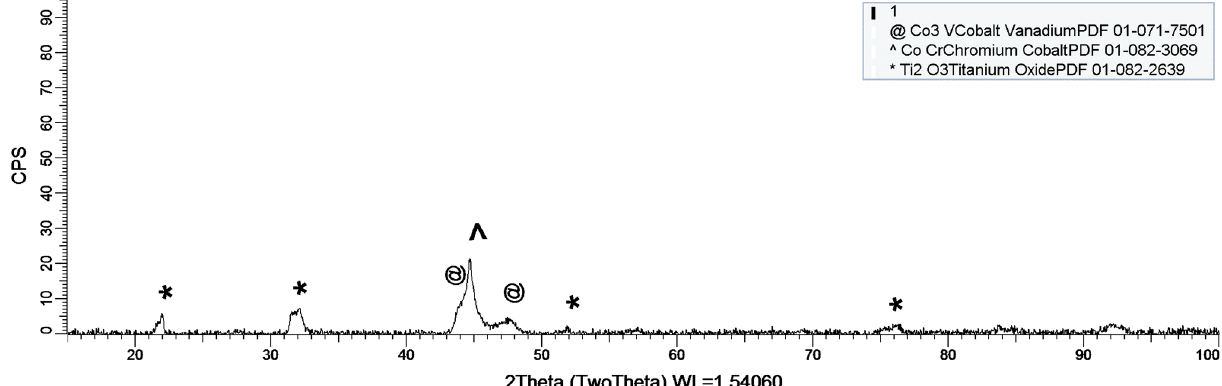
Figure 2. XRD plot for the 3D-printed CoCrMo metallic implant.